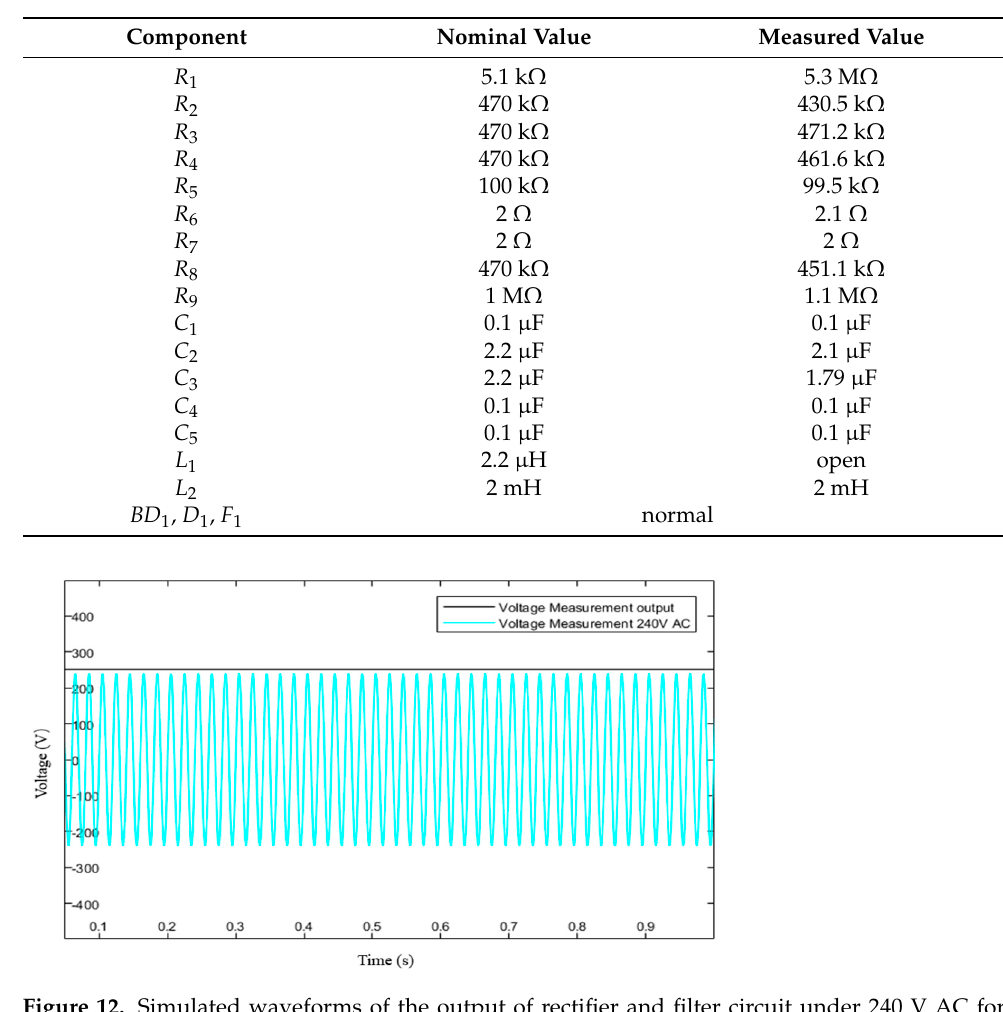
Table 4. Comparison of nominal and measured values of each component (Sample A).